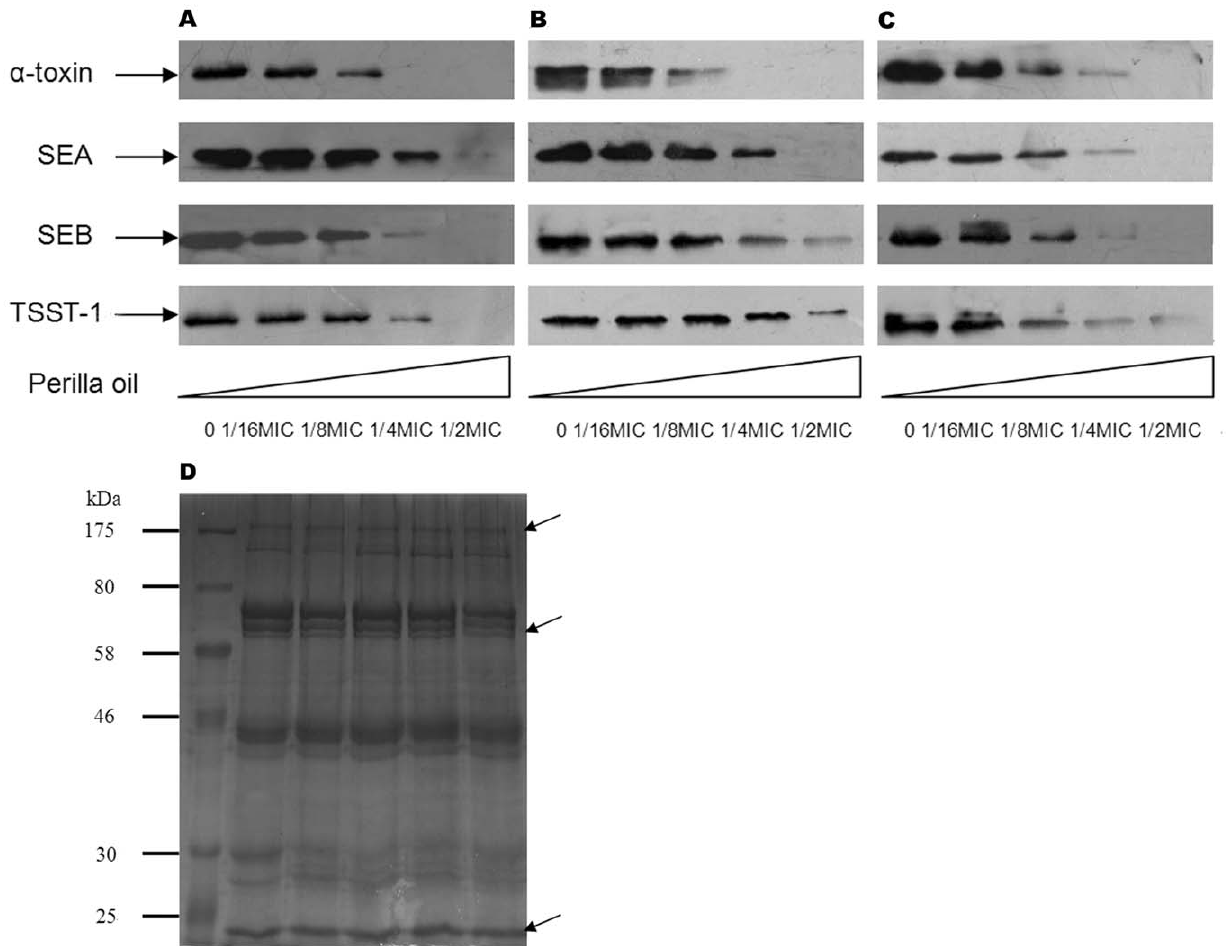
Figure 3. Western blot analysis of a -toxin, SEA, SEB, and TSST-1 production. S. aureus strains ATCC 29213 (A), MRSA 2985 (B) and MRSA 3701 (C) were grown in the presence or absence of increasing concentrations of perilla oil in MHB until the post-exponential growth phase. Equal amount of extracellular proteins were subjected to western blot analysis. (D) Coomassie-stained SDS-PAGE of secreted proteins by S. aureus strain ATCC 29213, arrows indicate the proteins that are not influenced by perilla